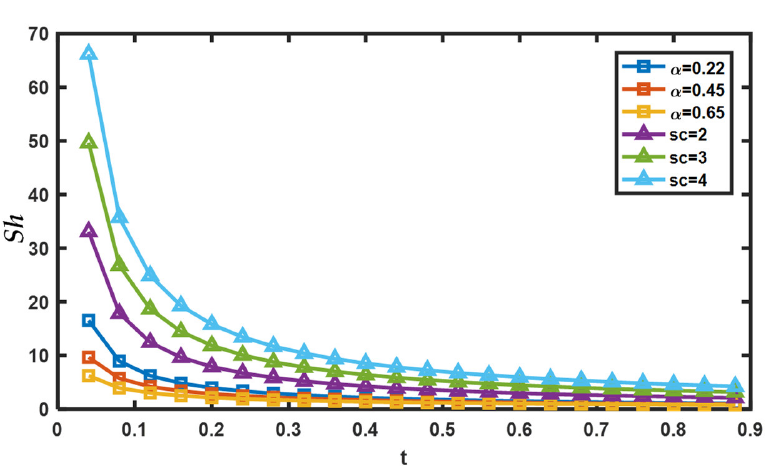
Figure 14. Variation of